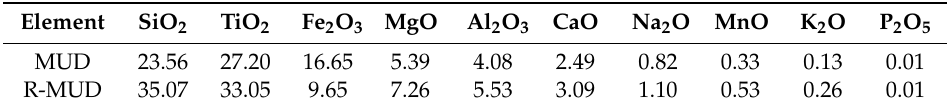
Table 2. Concentration (%) of major elements in sample of waste before (MUD) and after rinsing (R-MUD) (Data from reference [4]).